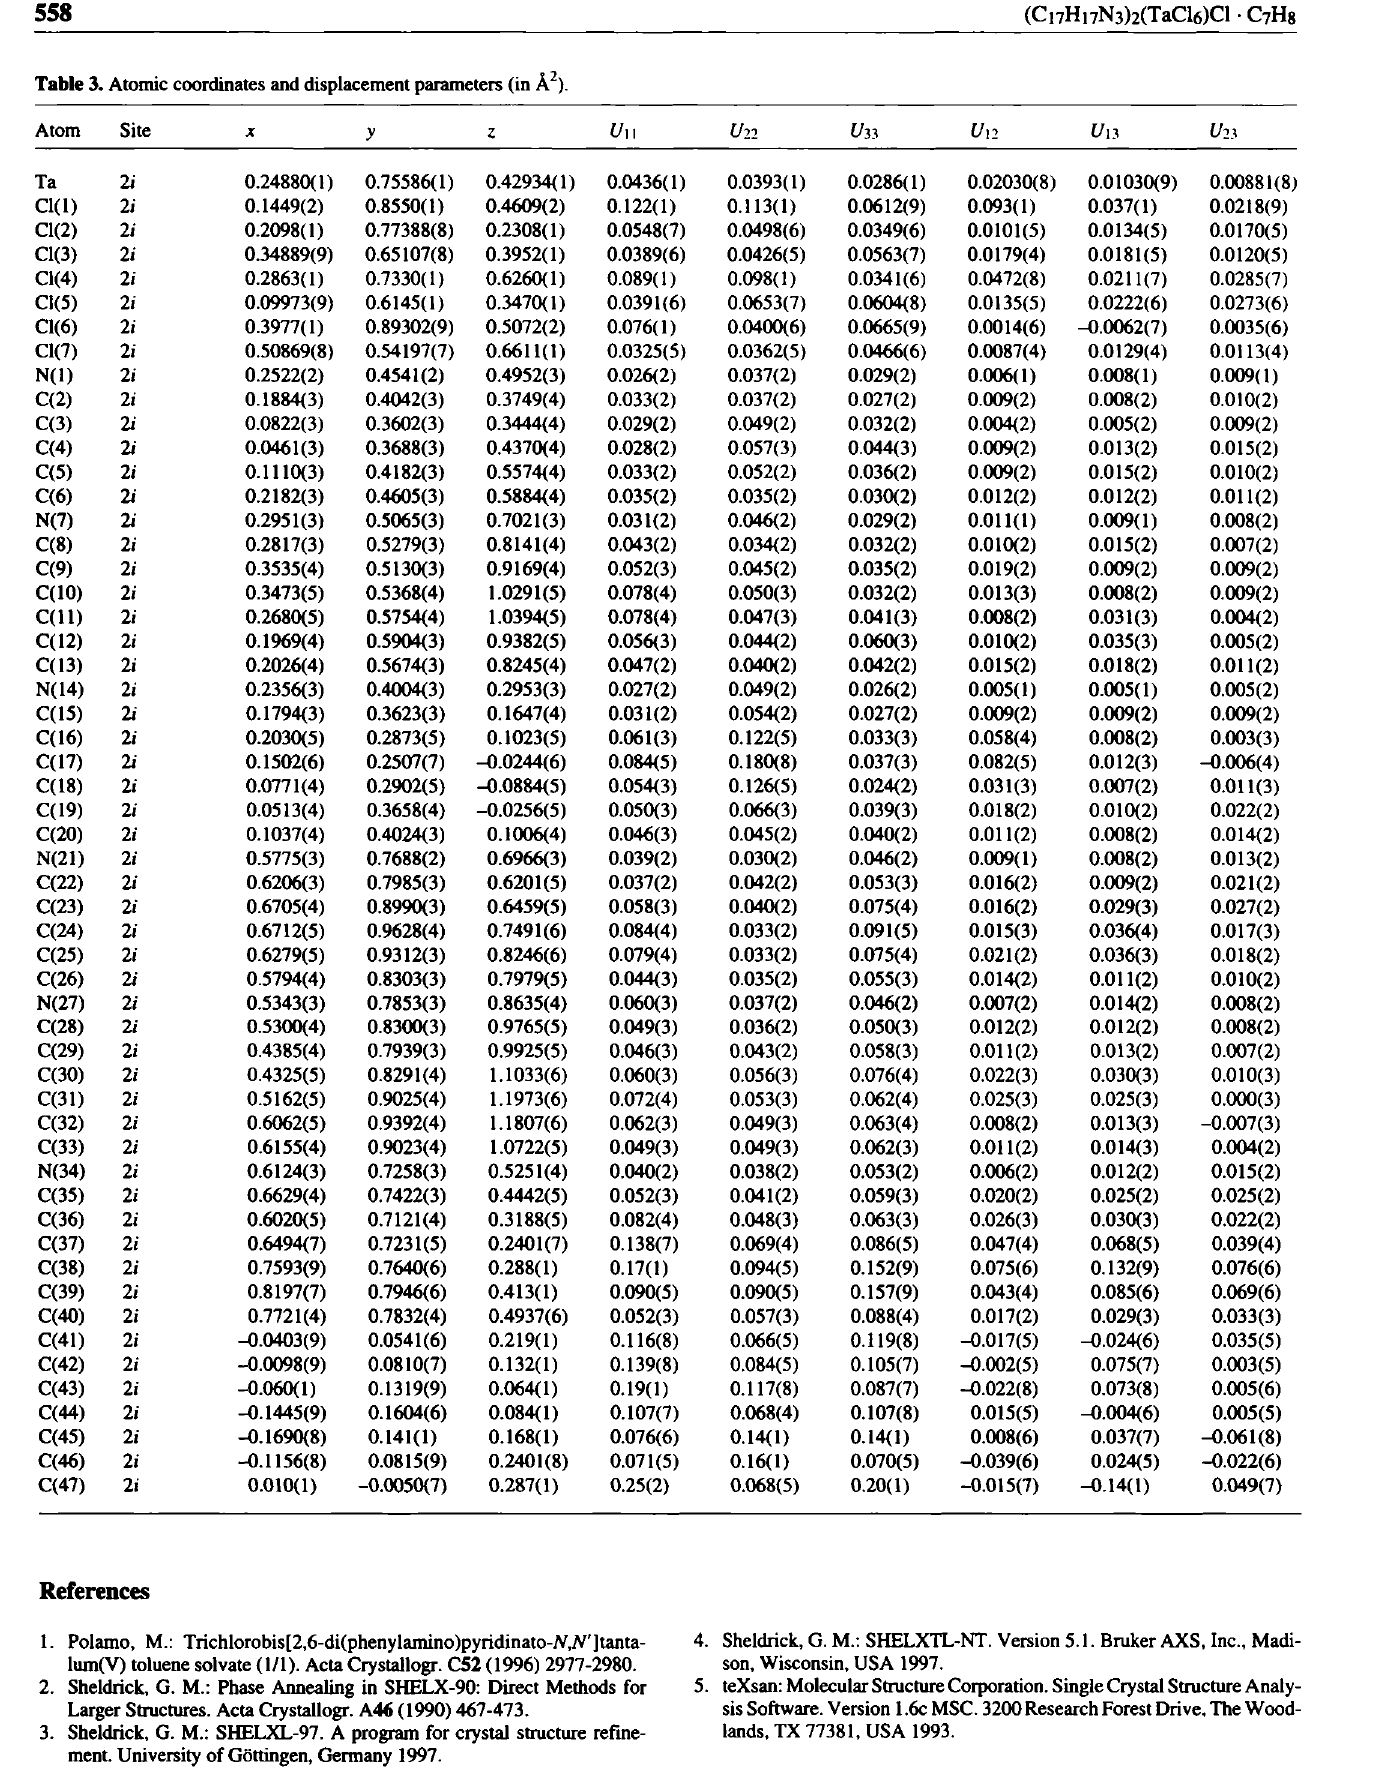
Table 3. Atomic coordinates and displacement parameters (in À 2